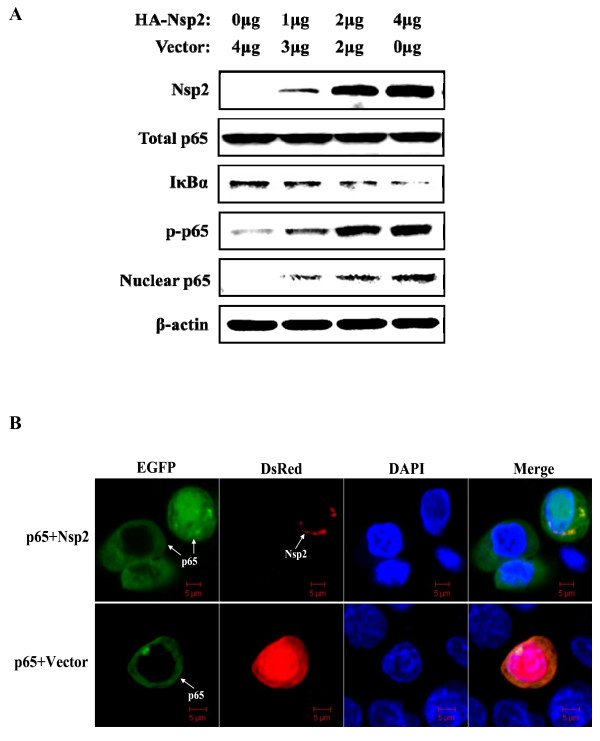
Degradation of IκBα and nuclear translocation of p65 are induced by PRRSV Nsp2. (A) HeLa cells were transfected with the indicated amount (0, 1, 2, 4 μg) of Nsp2 expression plasmid. Cytoplasmic and nuclear extracts were prepared at 48 h post-transfection and subjected to western blot analysis with antibodies specific for endogenous IκBα, p65 or p-p65. Mouse anti-HA was used to confirm the expression of HA-conjugated Nsp2 protein. Anti-β-actin was included as a control for sample loading. Western blot analyses were repeated in two independent experiments with similar results and a representative blot was shown. (B) HeLa cells were co-transfected with RFP-tagged Nsp2 expression plasmid (pDsRed-Nsp2) and the EGFP-tagged p65 expression plasmid (pEGFP-p65). Cells co-transfected with pDsRed-C1 and EGFP-tagged p65 served as a negative control. Cells were fixed and permeabilized at 36 h post-transfection. Cellular nuclei were counterstained with 1 μg/mL of DAPI (4',6-diamidino-2-phenylindole, dihydrochloride). Nuclear translocation of NF-κB was observed under an LSM-510 Meta confocal fluorescence microscope. Scale bar represents 5 μm.